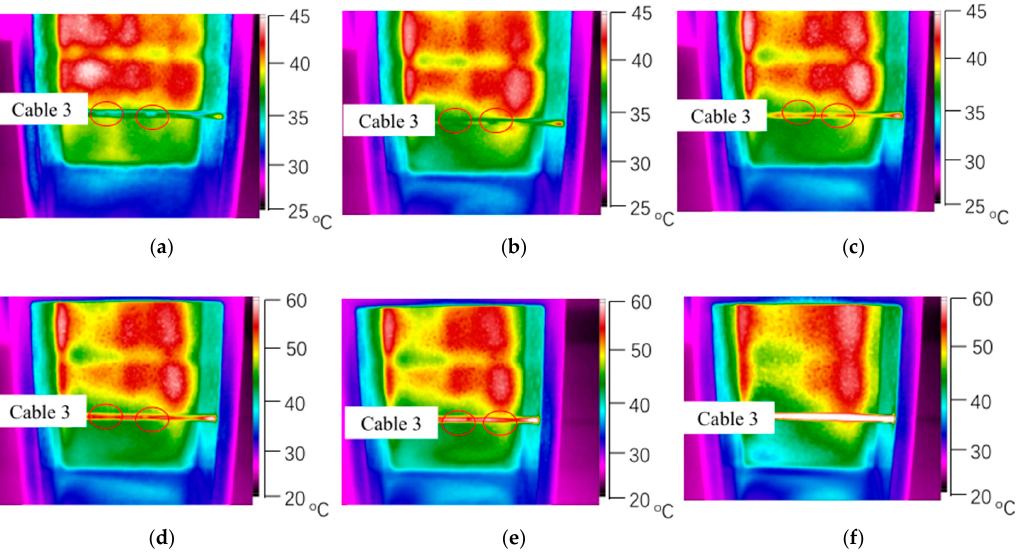
Figure 6. Surface temperature distribution of the Group #2 cables at different times during the heating phase (defects are on the front of the cable). ( a ) Heating up for 20 s. ( b ) Heating up for 40 s. ( c ) Heating up for 60 s. ( d ) Heating up for 80 s. ( e ) Heating up for 100 s. ( f ) Heating up for 120 s.